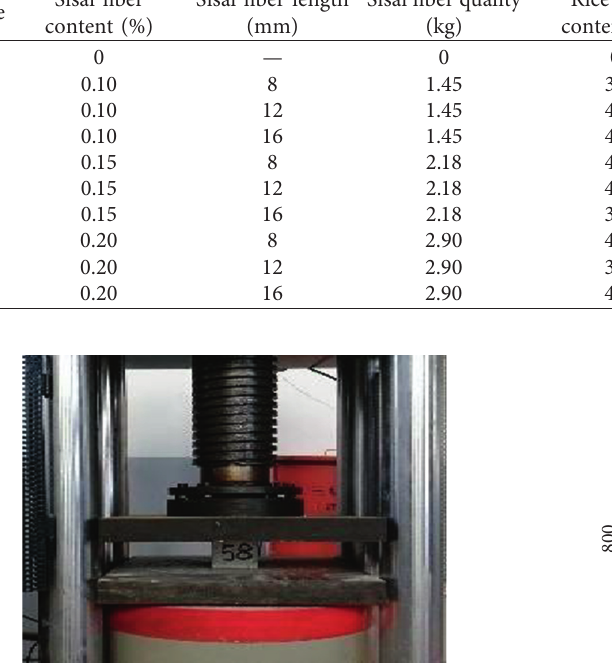
Figure 1: Compression test of sisal fiber husk mortar.